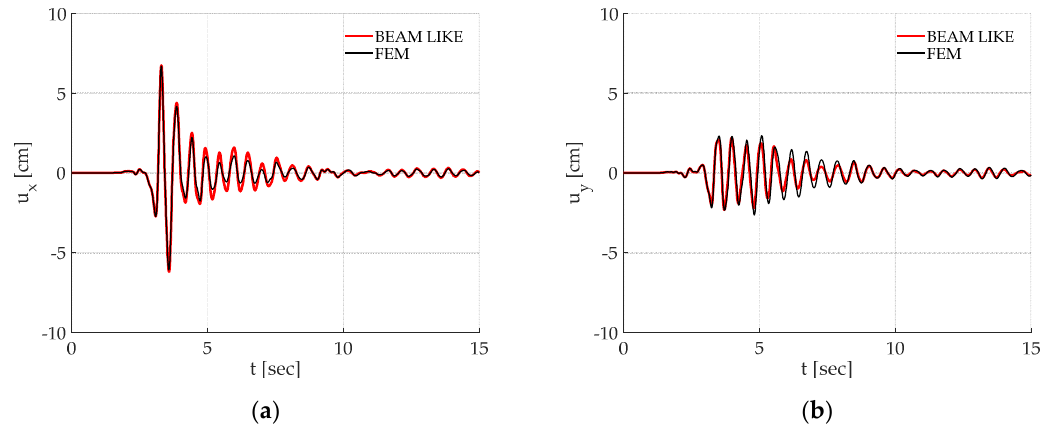
Figure 8. Four-storey benchmark. Santa Venerina earthquake. Displacements time history along the ( a ) x and ( b ) y direction.